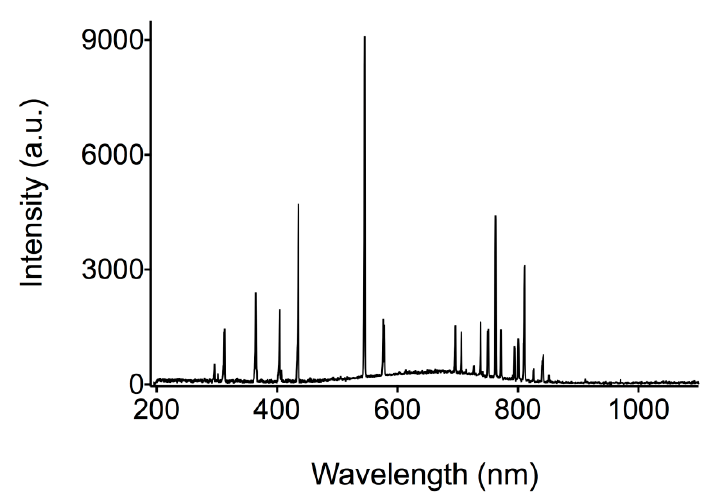
Figure 7. UV-Light source